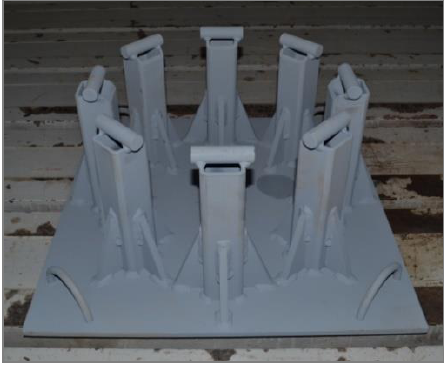
Figure 7. Experimental design of the circular supporting pattern-section AA’ (dimensions in mm).